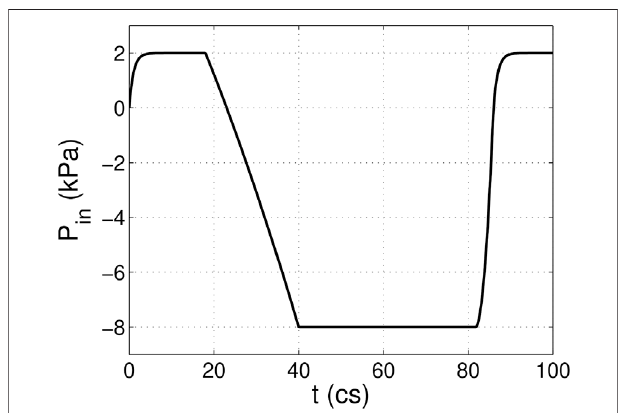
FIGURE 2 | Pressure load applied at the inlet of the aorta tube in the FSI simulation, where cs denotes centiseconds.